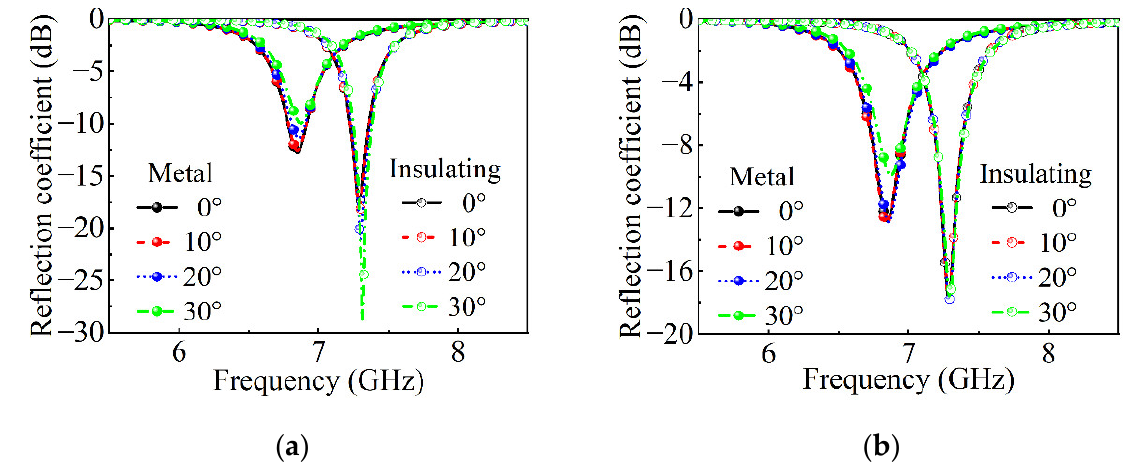
Figure 8. Full-wave simulation of the absorbing metasurface unit cell about the angle of incidence. ( a ) The reflection coefficient in TE mode in the metal state and the insulating state. ( b ) The reflection coefficient in TM mode in the metal state and the insulating state.